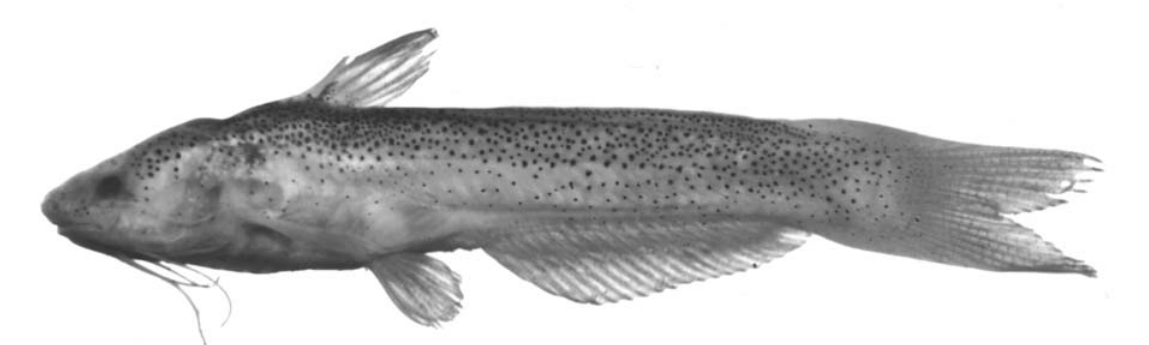
Fig. 3 . Cetopsidium minutum , ANSP 175839, 21 mm SL; Guyana, Siparuni VIII-2, Essequibo River at Essequibo campsite (4°45’41"N,